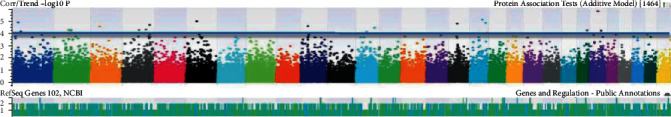
Identification of genomic coordinates on Manhattan plots associated with protein in the chromosomes of Capra hircus.